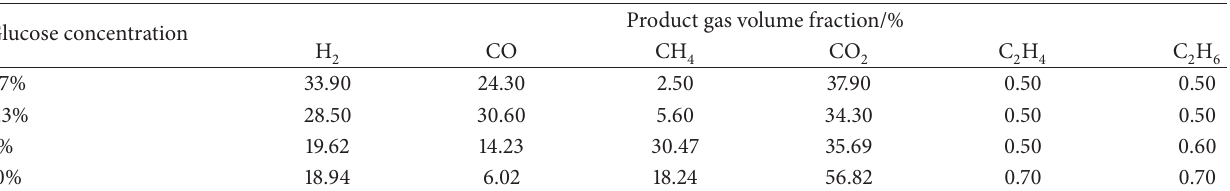
Table 1: The product gas volume fraction of different mass concentration of glucose solution gasification in SCW by Method 1 (600 ∘ C; 25 MPa).